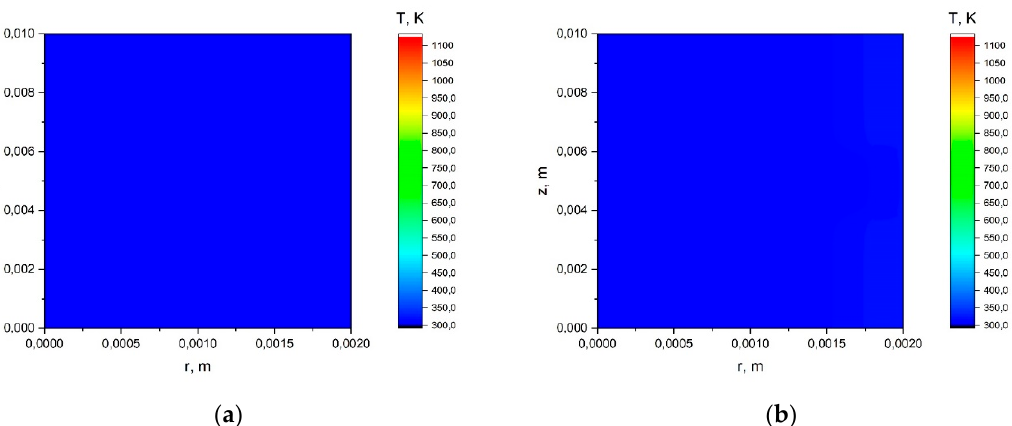
Figure A15. Temperature distribution in the stem of a herbaceous plant: R = 0.002 m, t = 0.5 s, q = 0.5 kW/m 2 ( a ); R = 0.002 m, t = 0.5 s, q = 3 kW/m 2 ( b ).